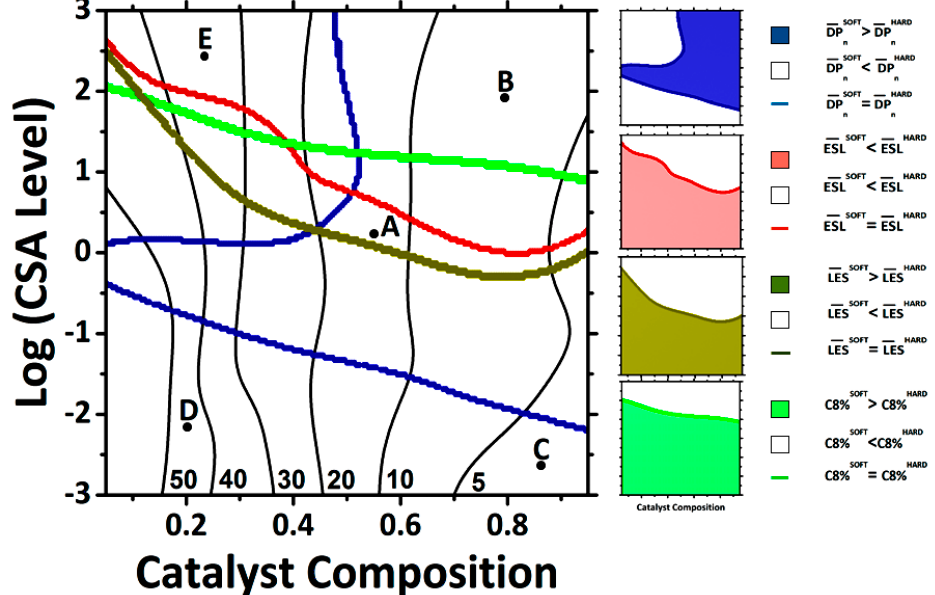
Figure 2. A “fingerprint” of chain-shuttling copolymerization decoded by the IMT (which visualizes different classes of OBCs all having a monomer molar ratio of 0.75, but a different blocky nature). Values (50 to 5) appearing at the bottom of the plot close to the black curves represent copolymers having a specified hard block percent ( HB% ). CSA, chain-shuttling agent; DP, average degree of polymerization; ESL, ethylene sequence length; LES, longest ethylene sequence length.